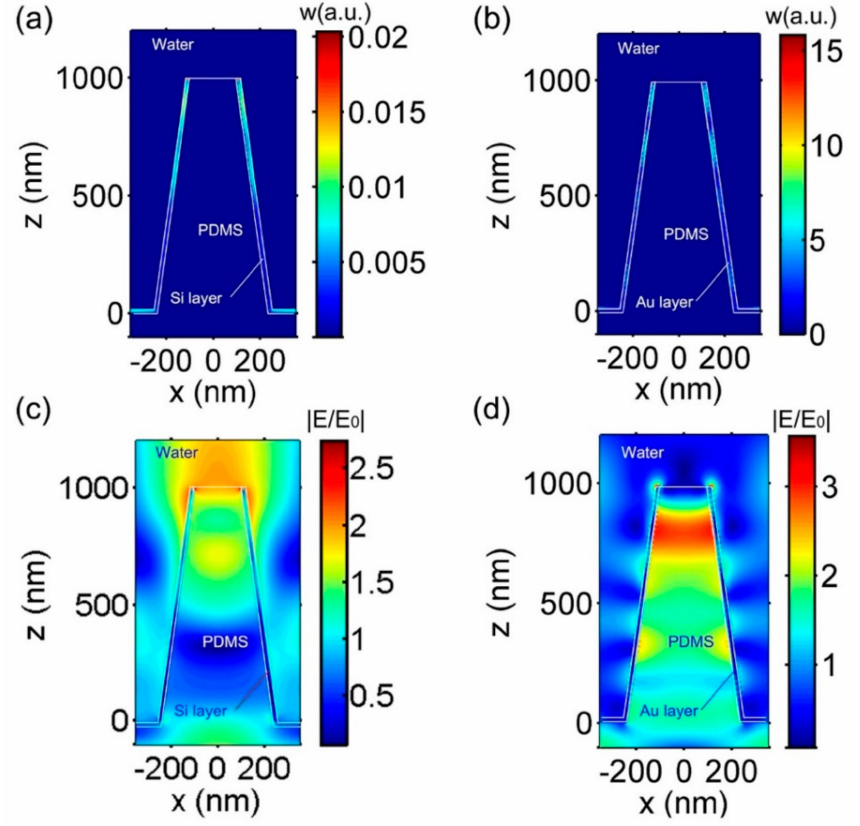
Figure 2. 758 nm power dissipation distribution for cross sections of ( a ) Si-coated ( b ) Au-coated cones without nanorod. 758 nm electric distribution for cross sections of ( c ) Si-coated ( d ) Au-coated cones without